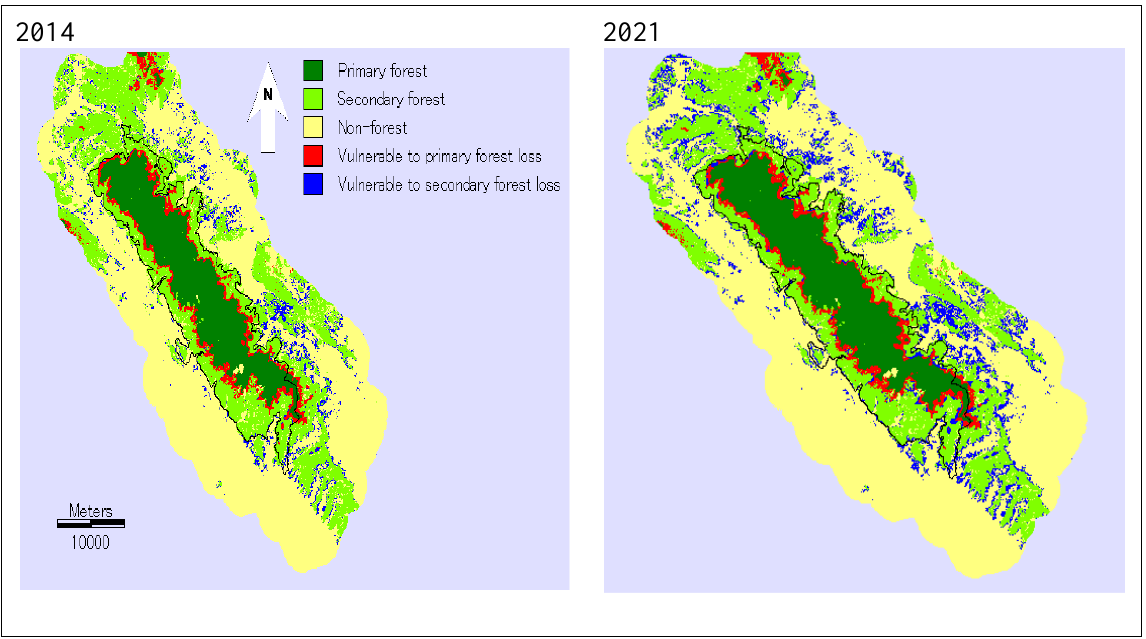
Figure 11. Predicted forest cover and areas vulnerable to forest changes in 2014 and 2021.